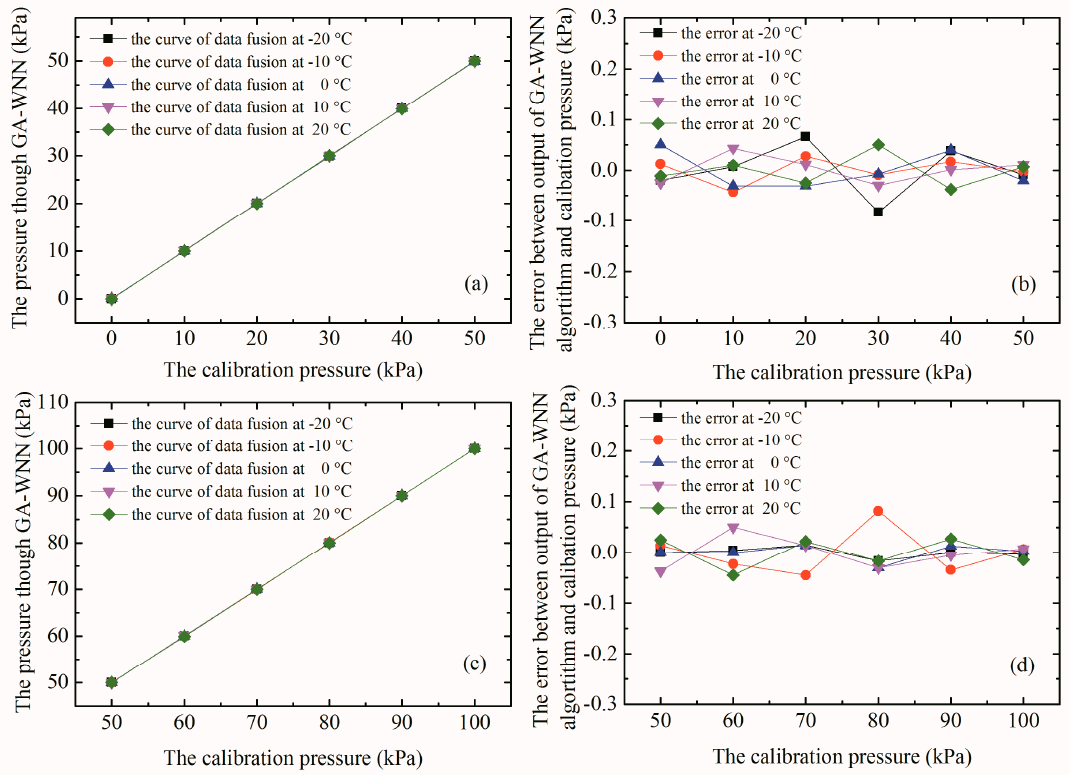
Figure 19. ( a ) The relationship curves between the corrected pressures of PS1/PS2 sensor and the calibration pressures with pressure from 0–50 kPa; ( b ) the absolute error between the corrected pressures of PS1/PS2 sensor and the calibration pressures at different temperature; ( c ) the relationship curves between the corrected pressures of PS3/PS4 sensor and the calibration pressures with pressure from 50–100 kPa; and ( d ) the absolute error between the corrected pressures of PS3/PS4 sensor and the calibration pressures at different temperature.